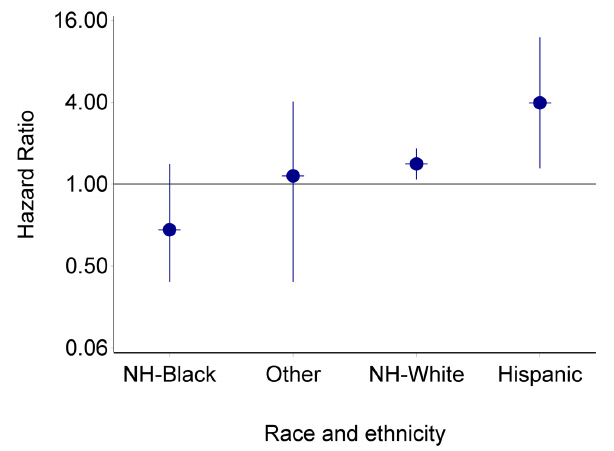
Model 1: age adjusted model. Model 2: adjusted for age, year of cancer diagnosis, race and ethnicity, disease stage, tumor size, and number of lymph nodes examined. CI: confidence interval, HR: hazard ratio. There was no significant association between radiotherapy (with or without chemother- apy) and CVD deaths. There was a significant interaction between race and ethnicity and cancer treatment on the risk of CVD mortality ( p = 0.005). The risk of CVD mortality was observed to be highest among Hispanic men (HR: 3.96, 95% CI: 1.31–12.02) (Figure 1).